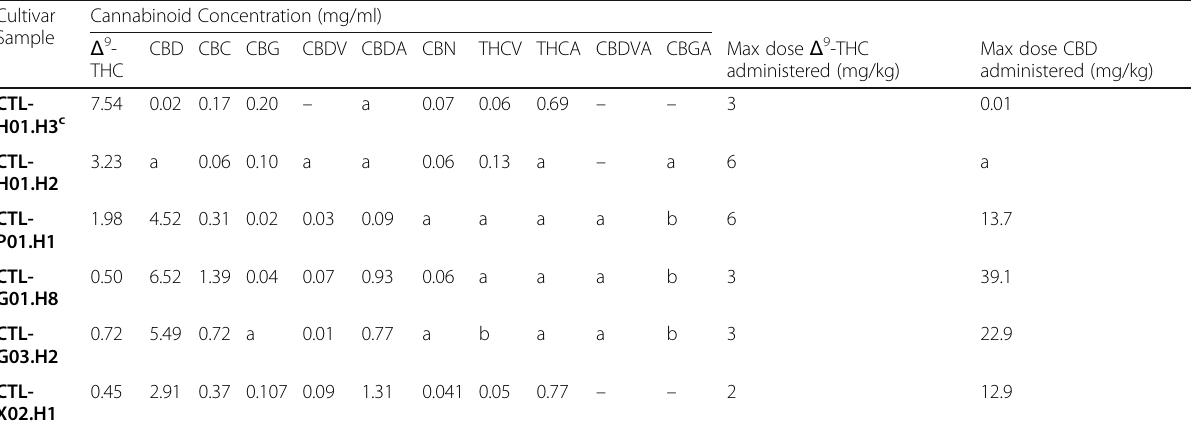
Table 2 The concentrations of Δ 9 -THC and CBD derived from each cannabis cultivar extract Cultivar Cannabinoid Concentration Sample